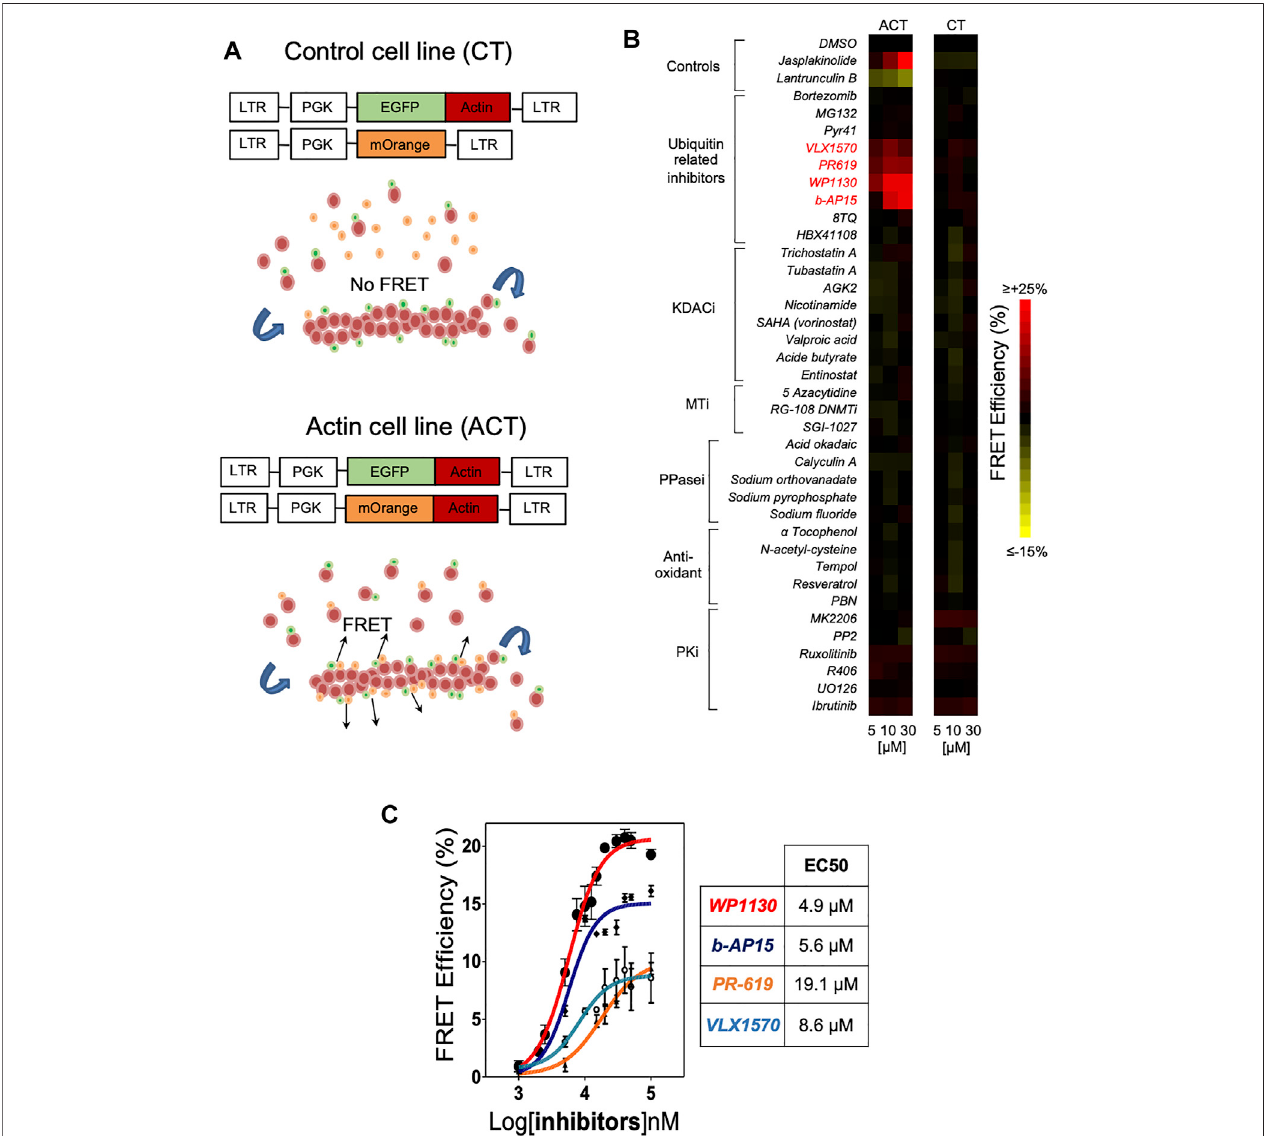
FIGURE 1 | High-content screening using Actin CytoFRET identi fi es deubiquitinase inhibitors as novel modulators of actin remodeling. (A) Actin CytoFRET principle:Actin-FRET (ACT) celllineexpresses EGFP-actin andmOrange-actin fl uorescent proteins (FPs). FRETsignals areemitted inFRET-ACT cellswhen EGFP-actin and mOrange-actin locate close to each other in actin fi laments. FRET-control (CT) cell line expresses EGFP-actin and mOrange alone that cannot be incorporated into actin fi laments, preventing FRET signal emission. FRET signals are monitored by fl ow cytometry using a ratiometric method. (B) Heatmap representation of Actin CytoFRET screening of a small library of compounds affecting post-translational modi fi cations. Each compound was tested at three concentrations (5, 10, 30 µM) for 60 minon ACT andCTreportercelllines and FRETsignalswererecorded by fl owcytometry.Dataareexpressed asthepercentage ofFRET ef fi ciency betweenDMSO- treated and compound-treated cells. Jasplakinolid and Latrunculin B were tested as controls for actin polymerization and depolymerization, respectively. (C) Dose- response determination of the activity of DUBi WP1130, b-AP15, PR-619 and VLX1570 on actin FRET ef fi ciency. Data represent the mean ± SD of n (cid:2) 3 independent experiments. EC50 for each drug were calculated using GraphPad Prism